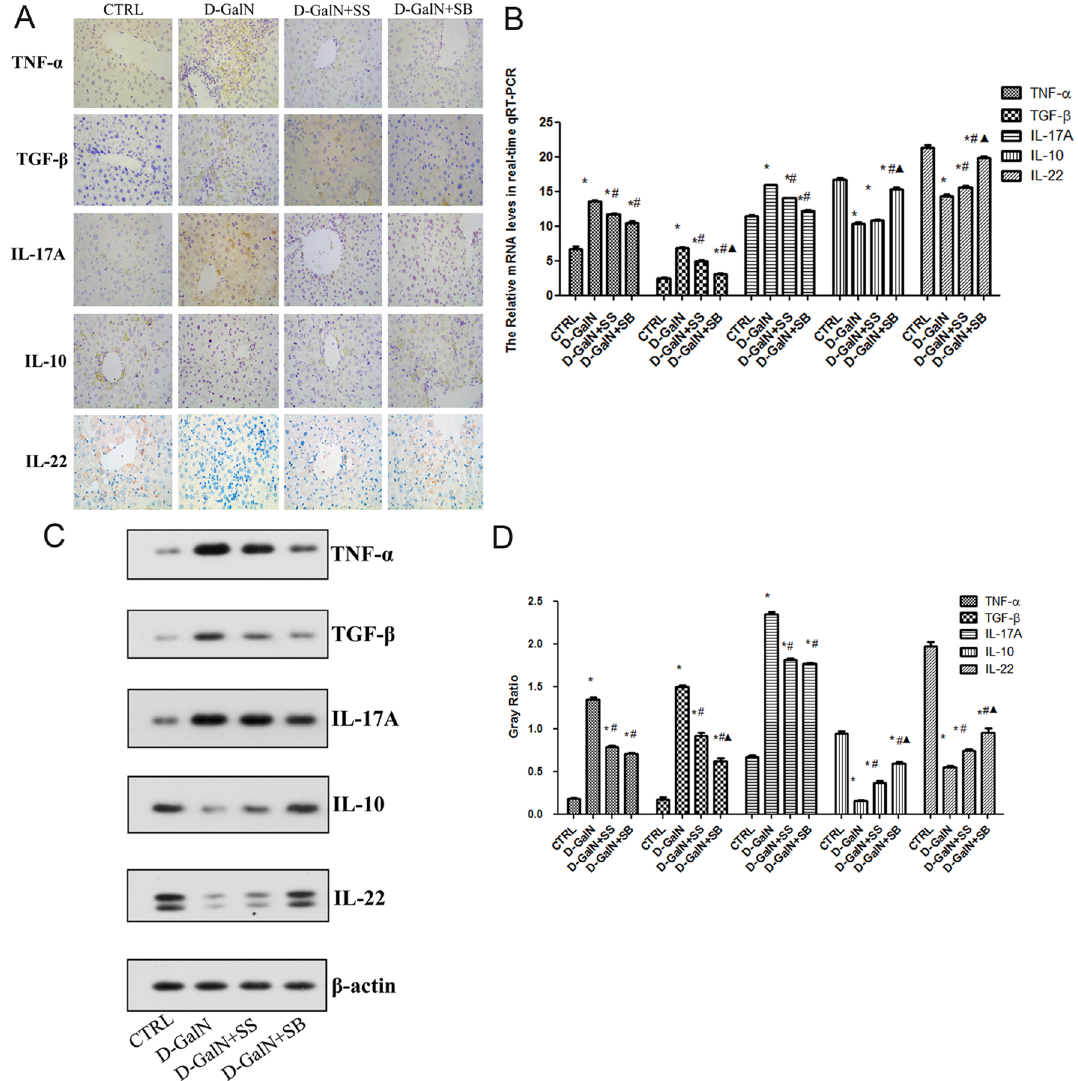
Figure 5. Expression levels of TNF-α, TGF-β, IL-17A, IL-10, and IL-22 in liver tissues of each group. ( A ) Immunohistochemical analysis of TNF-α, TGF-β, IL-17A, IL-10, and IL-22 in each group (× 400). ( B ) The mRNA expression of TNF-α , TGF-β , IL-17A , IL-10 , and IL-22 in each group by qPCR. ( C ) Western blotting for TNF-α, TGF-β, IL-17A, IL-10, and IL-22. ( D ) Gray ratio by western blotting. * P < 0.05 compared with control group; # P < 0.05 compared with d-GalN group; △ P < 0.05 compared with D-GalN + SS